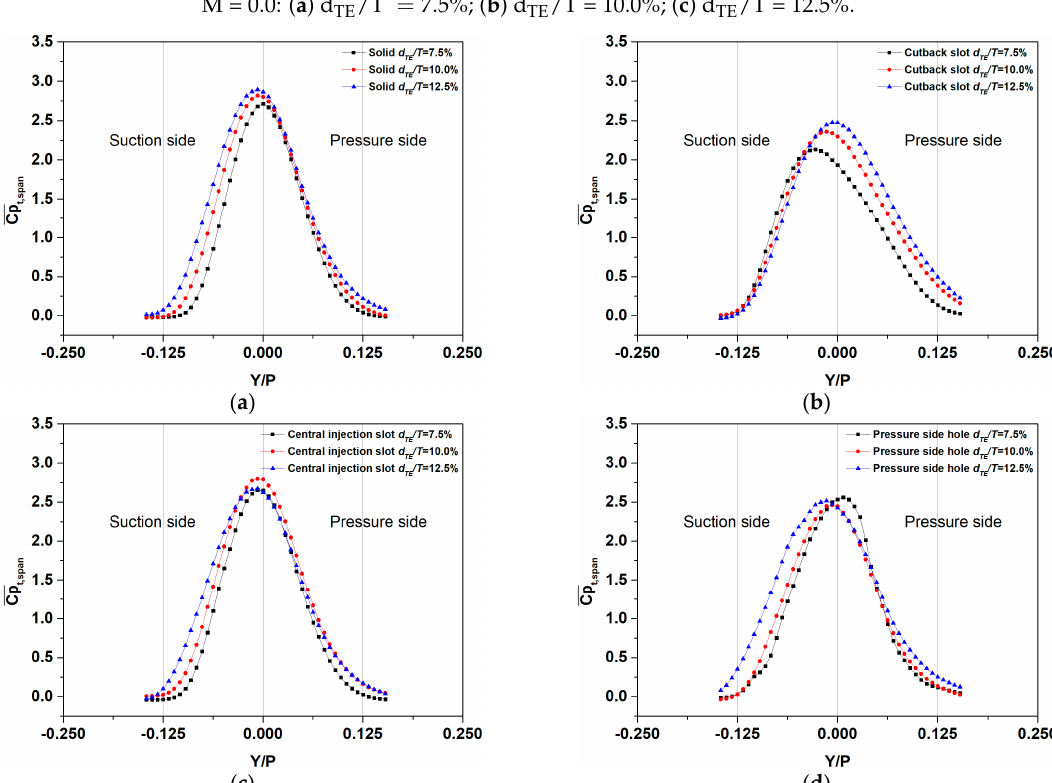
Figure 9. Spanwise averaged total pressure loss coefficient showing the effect of the trailing edge diameter: ( a ) solid; ( b ) cutback slot; ( c ) central injection slot; ( d ) pressure side hole.